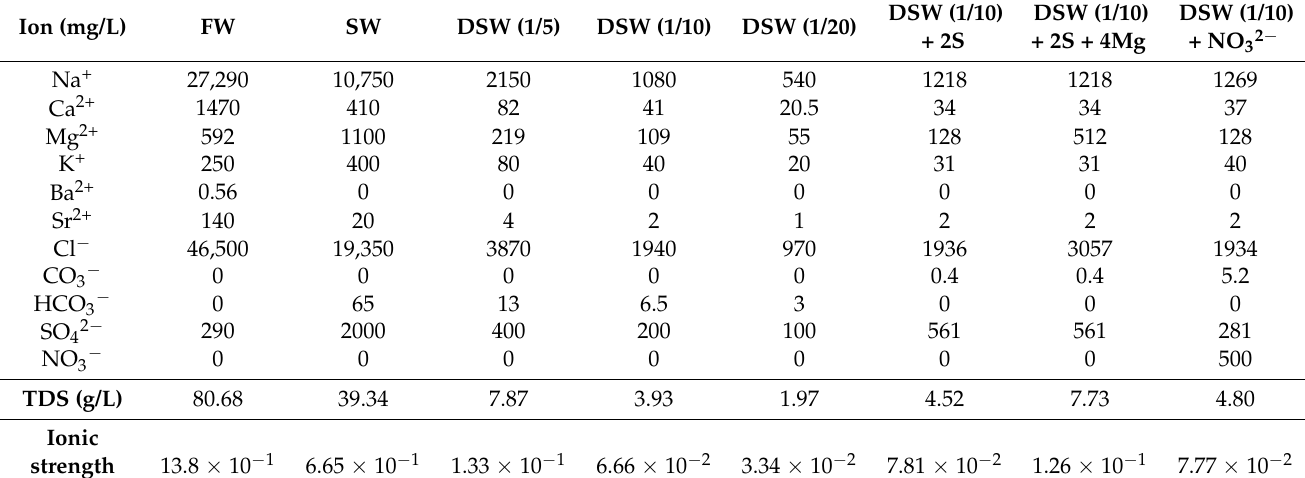
Table 1. Calculated ion concentrations of synthetic brines in core flooding experiments according to Danish North Sea reservoir fluids and